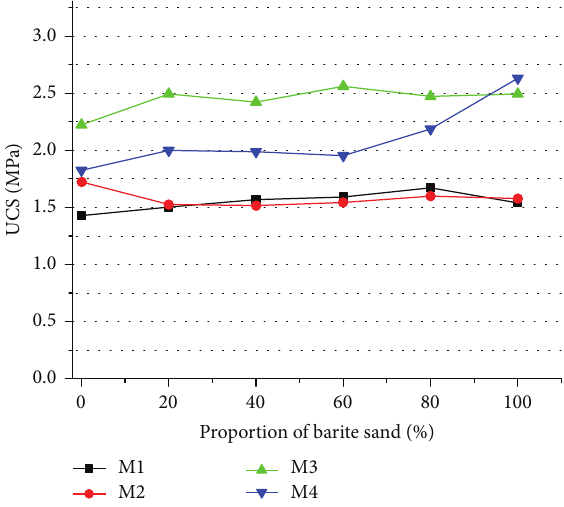
Figure 4: UCS versus the proportion of barite